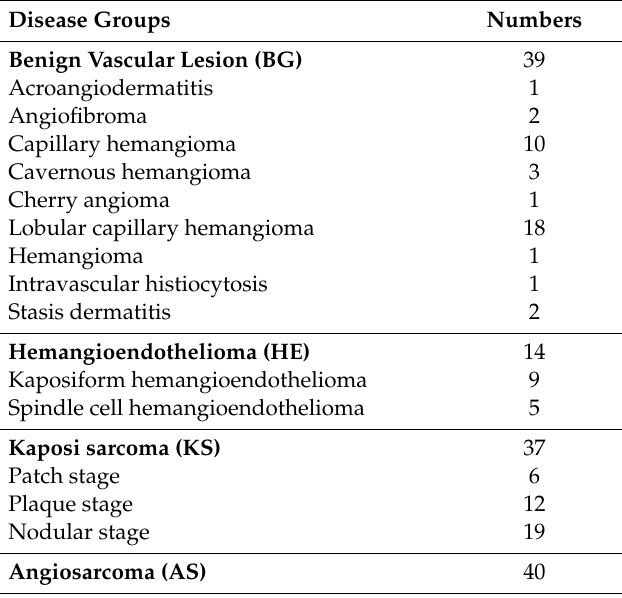
Table 3. Detailed diagnosis of disease groups ( n =